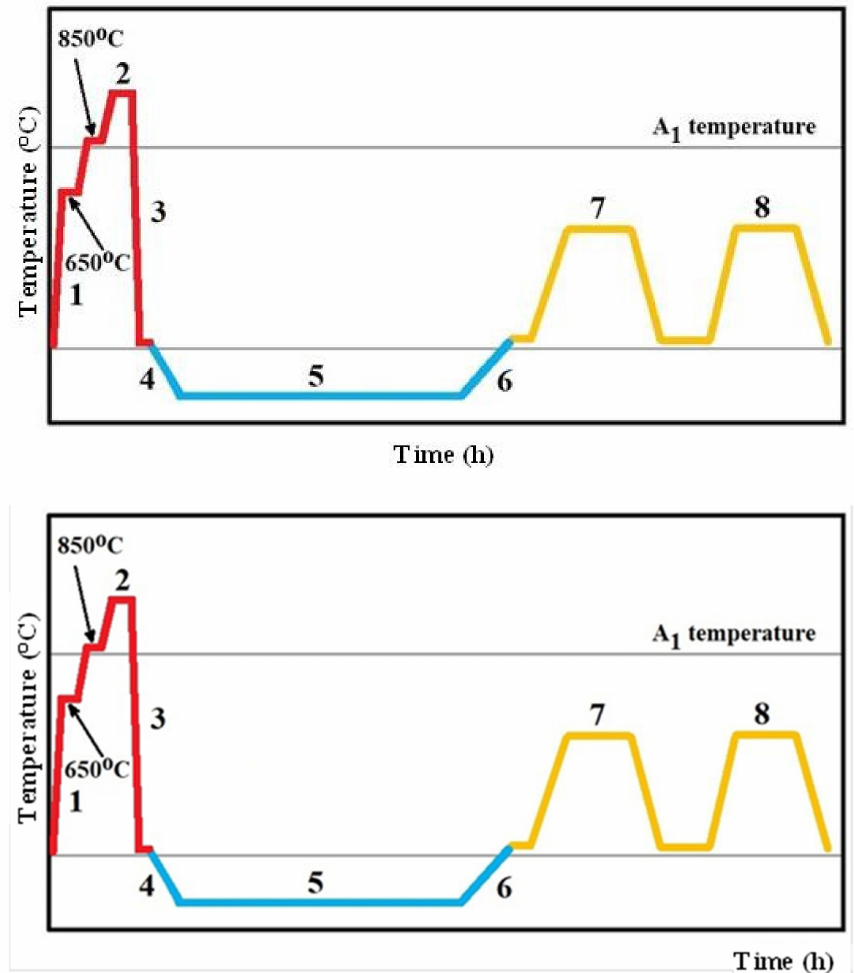
Figure 1. A schematic of the heat treatment schedules